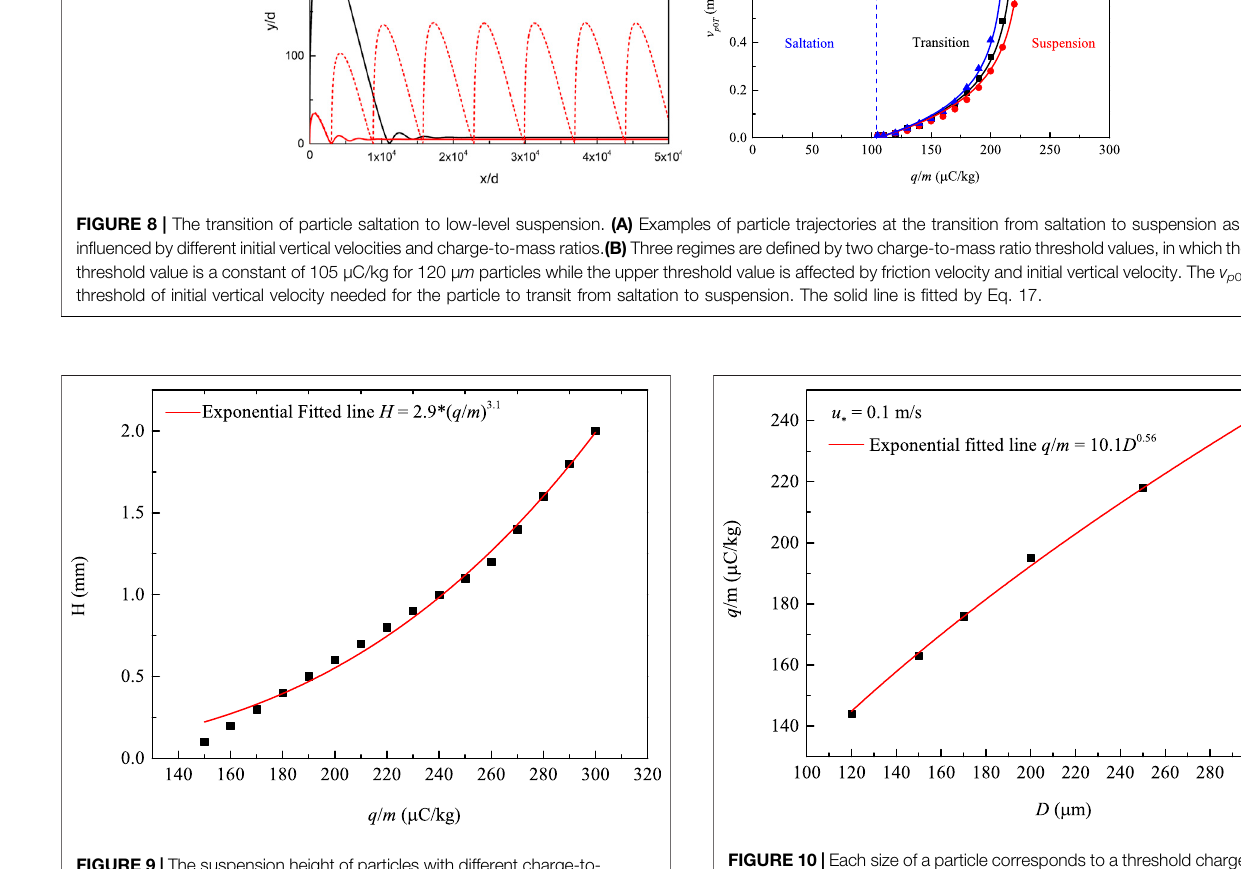
FIGURE 9 | The suspension height of particles with different charge-to- mass ratios.